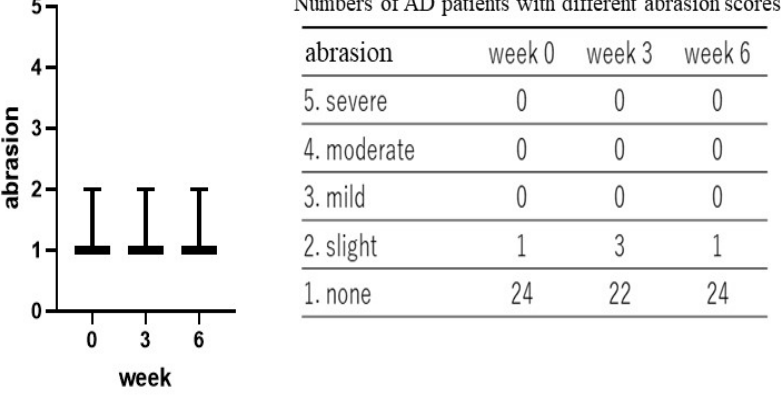
Figure 3. Clinical effects of the POLG nano-emulsion on papules of the skins of AD patients. Papule scoring was performed by a dermatologist (KN) at 0, 3, and 6 weeks on a 1–5 grading basis (1 = none; 2 = slight; 3 = mild, 4 = moderate; 5 = severe). n = 25. All data were analyzed using Dunn’s multiple comparisons test.